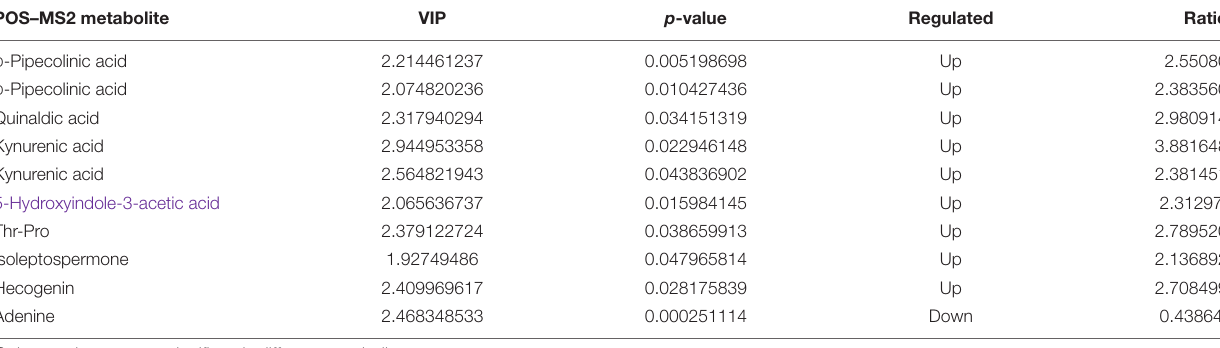
TABLE 2 | Statistics of identified metabolites: Differences in metabolites in the colon of RES and diquat groups in positive ion model. POS–MS2 metabolite